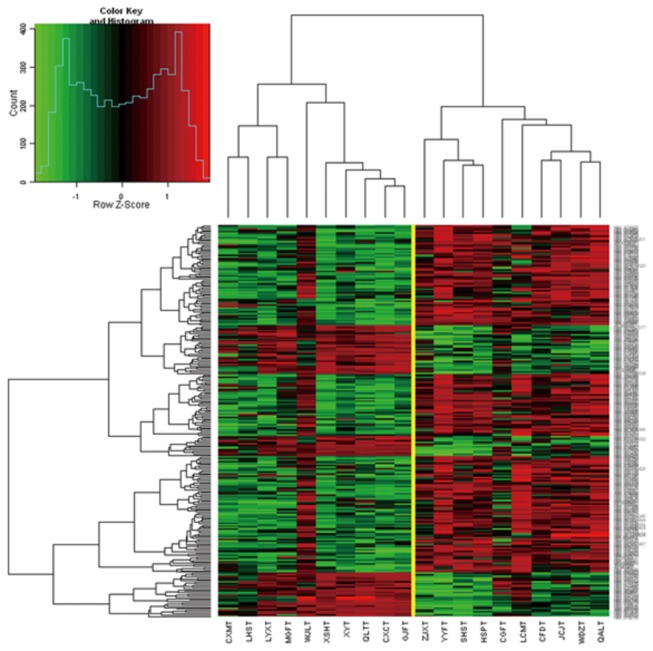
Expression data matrix of 371 potential prognostic markers genes from tumors of 20 gastric cancer patients hybridized using the custom microarray.Each column represents a tumor and each row a gene. The length and the subdivision of the branches display the relatedness of the GC (bottom) and the expression of the genes (right). The yellow line marks the subdivision into two dominant clusters. The expressions of genes between two groups have significant differences, fold change log2 >=1 or <= -1, P<0.01.